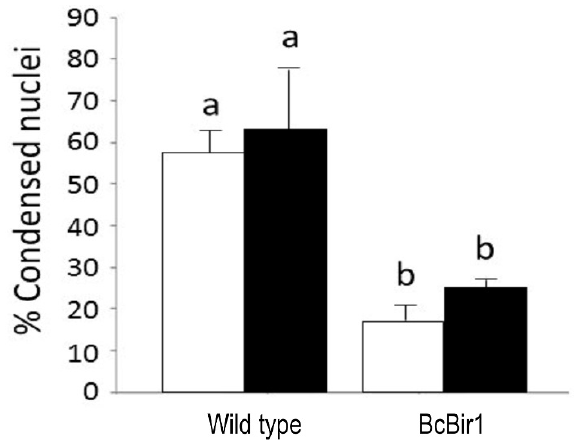
FIGURE 4: Quantification of chromatin condensation in hyphae of B. cinerea wild type and BcBIR1 strains. Fungi were grown for 24 h in PDB medium at 22°C after which H 2 O 2 was added to a final concentration of 10 mM. The cultures were incubated for addi- tional 4 h, samples were removed, stained with Hoechst 33342 and then visualized at 1000x magnification. The percent of nuclei with condensed chromatin was scored and calculated manually (white bars), or by the Condensation module of the SCAN © soft- ware (black bars). Data are the mean average ± SEM of three samples, each containing at least 200 nuclei (n = 3). Percentage of apoptotic nuclei in untreated cultures was lower than 15% (not shown). Columns and lines not connected with the same letter are statistically different according to two-way ANOVA (P < 0.05) followed by a post-hoc Tukey HSD analysis (P <